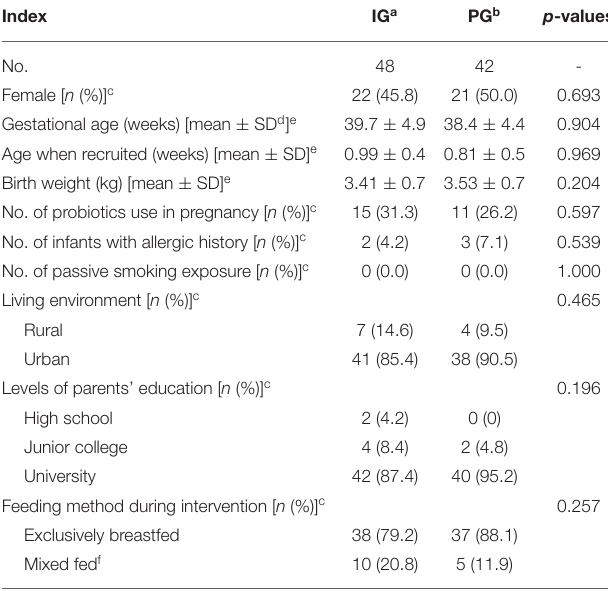
FIGURE 1 | Diagram of patient enrollment and study progress. TABLE 1 | Clinical and socioeconomic data of the